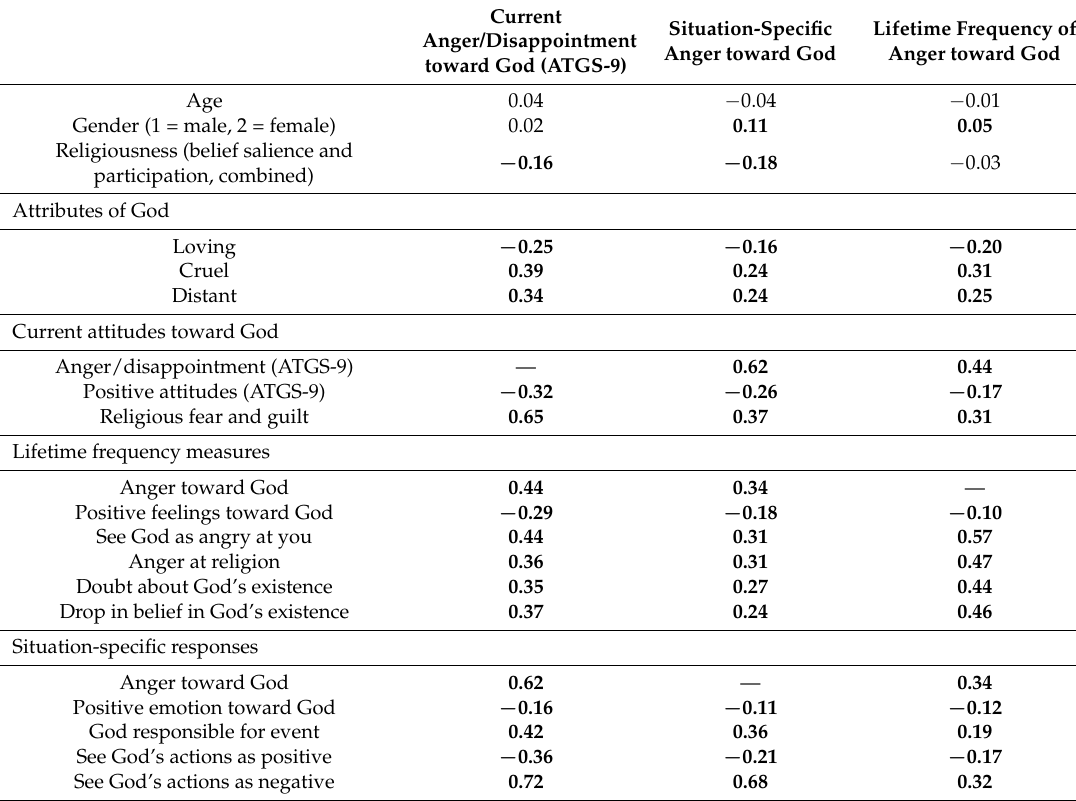
Table 4. Midwestern public university sample: Correlations between key study variables and three measures of anger toward God.